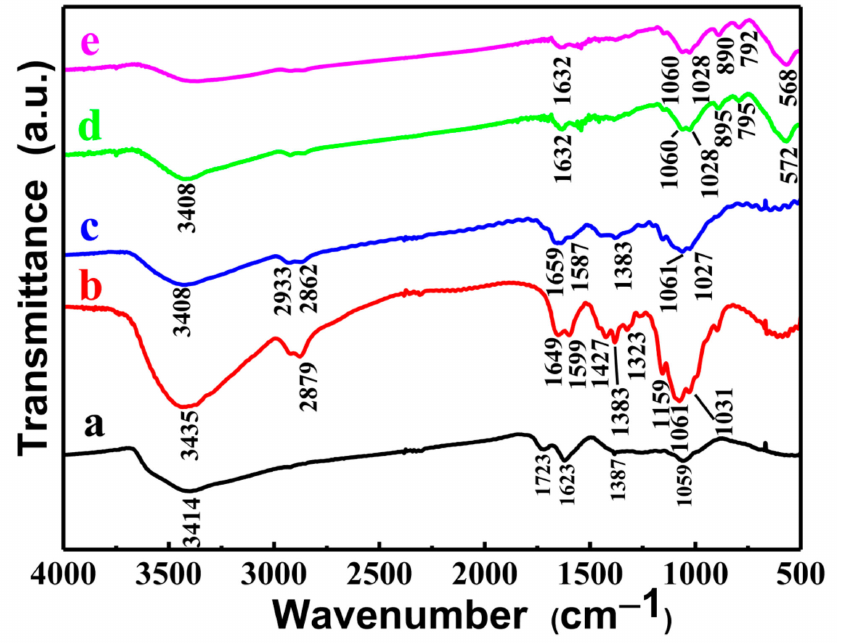
Figure 5. FTIR spectra of (a) GO, (b) CS, (c) GOCS, and MGOCS before (d) and after (e) As(III)